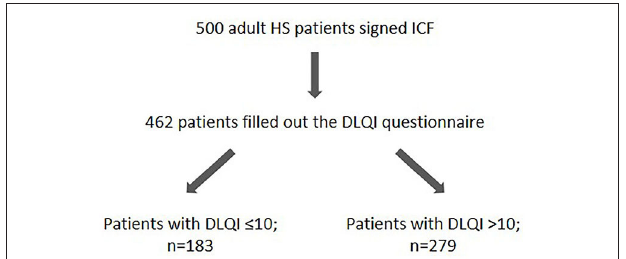
FIGURE 1 | Overview on the HS study population. The number of HS study participants as well as the number of patients showing a DLQI score ≤ 10 and DLQI > 10 are given. DLQI, Dermatology Life Quality Index; HS, hidradenitis suppurativa; ICF, informed consent